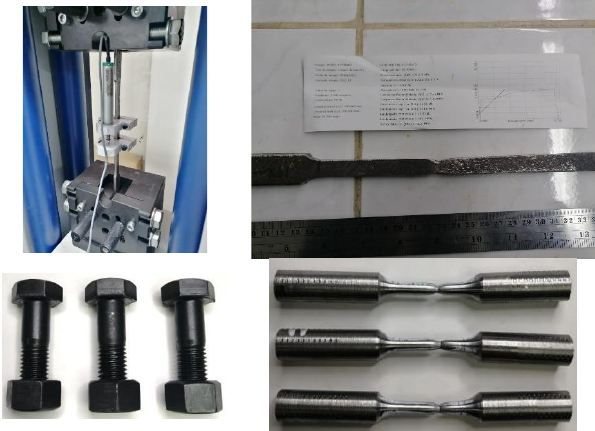
Figure 2. Test of steel plates samples. Table 1. Material properties of steel.